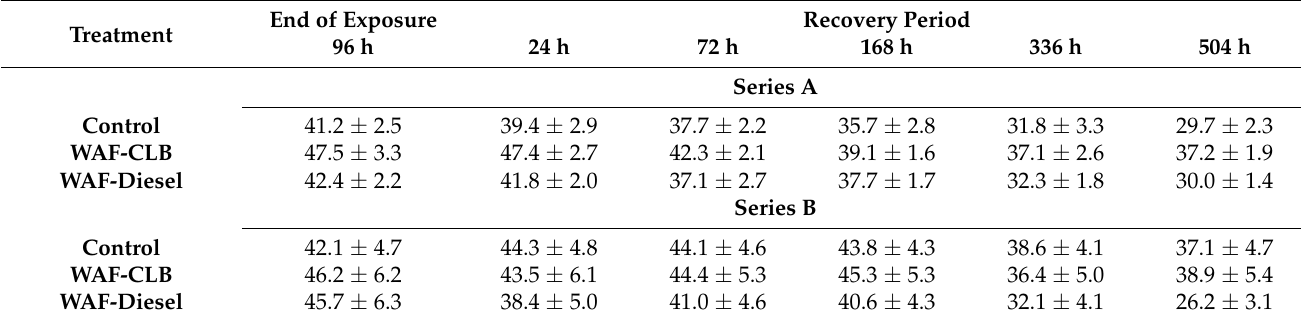
Table 3. Total protein content (mg/mL) in hemolymph, as calculated from measurements of the Brix index, of lobsters for each treatment (Control, WAF-CLB, and WAF-Diesel) during the recovery period in series A and B. Mean ± SE; n = 3. End of Exposure Treatment